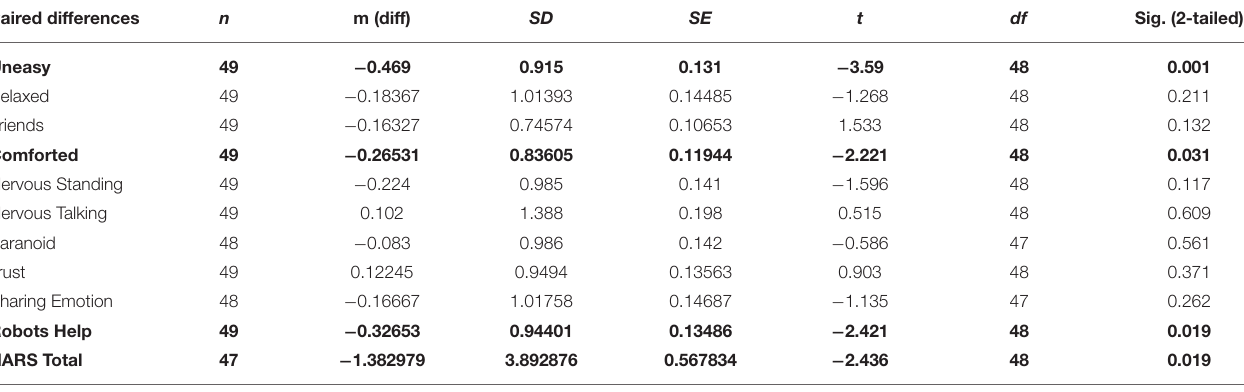
TABLE 3 | Participant change in NARS item.